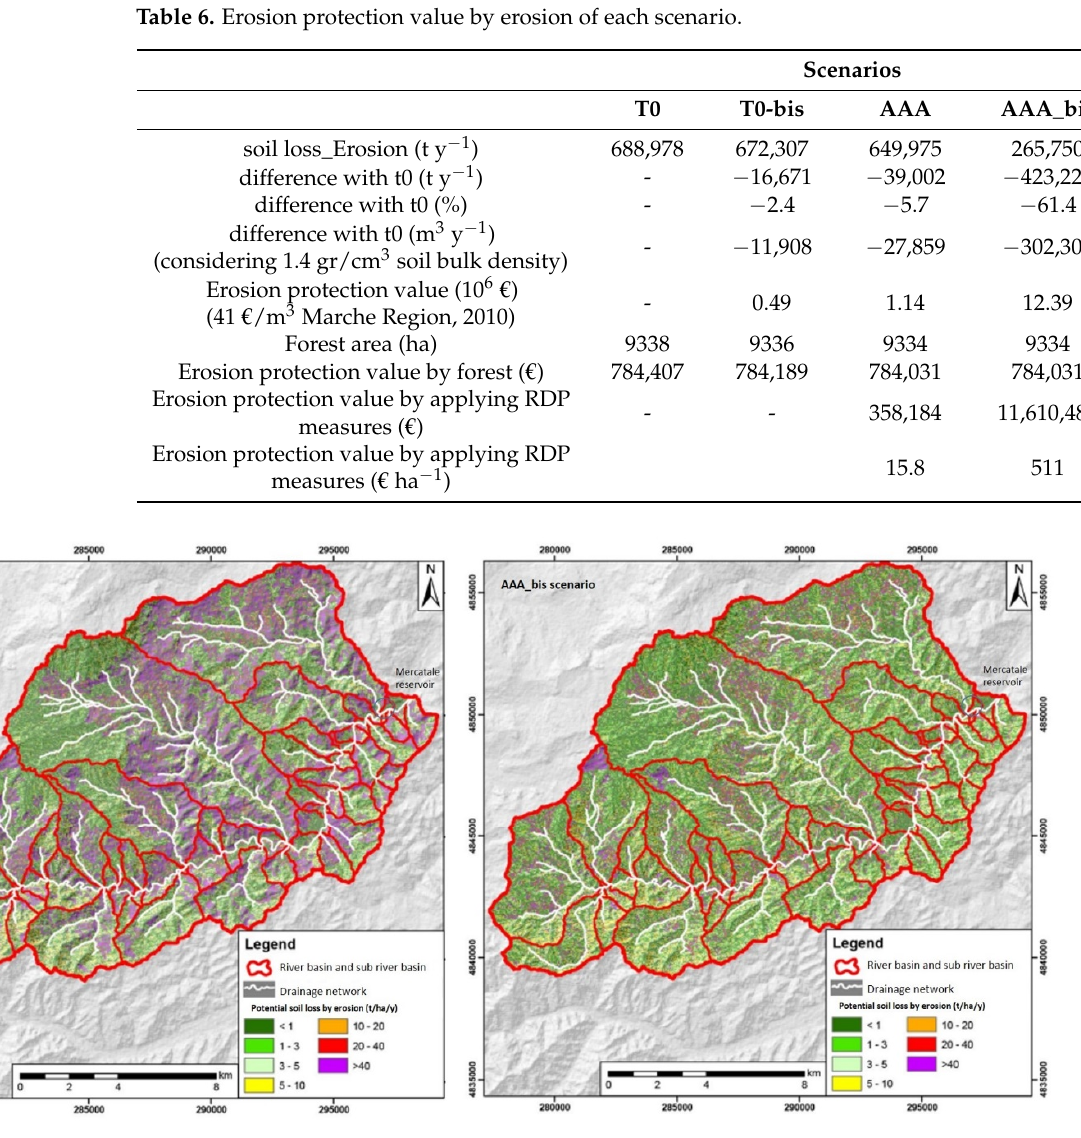
Table 6. Erosion protection value by erosion of each scenario.